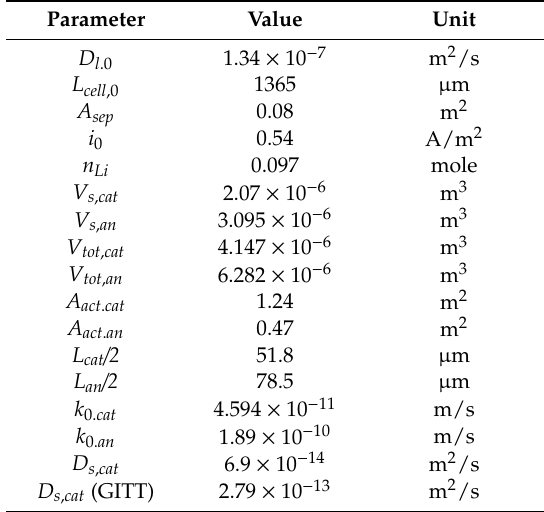
Table 5. Summary of battery parameters estimated in this